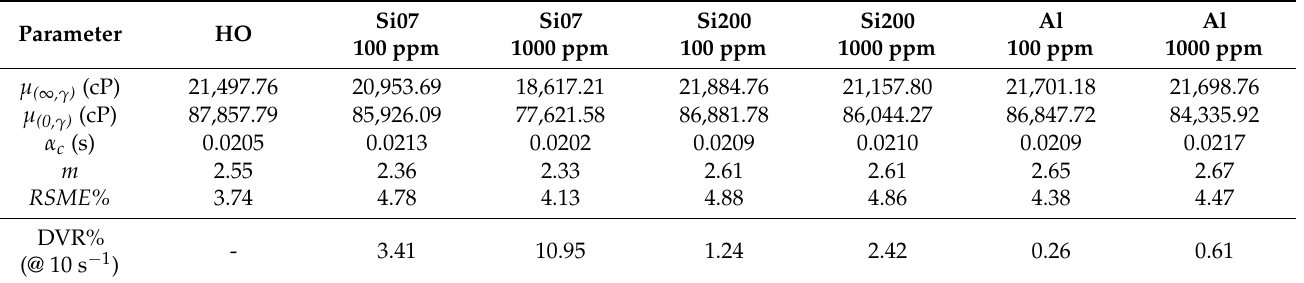
Figure 3. Viscosity as a function of shear rate at 25 °C for HO in the absence and presence of Si07, Si200 and Al nanoparticles at 100 and 1000 mg/L and fitted with the Cross rheological model. Table 4. Estimated parameters of the Cross rheological models for crude oil in the presence of Si07, Si200 and Al nanoparticles at 100 and 1000 mg/L and 25 °C.